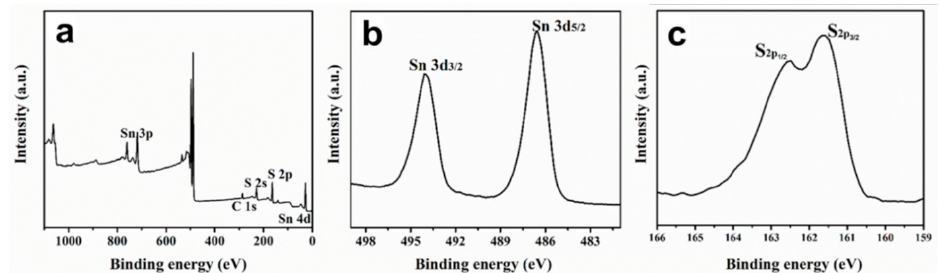
Figure 3. ( a ) XPS survey spectra; ( b ) Sn 4d XPS spectra; ( c ) S 2p XPS